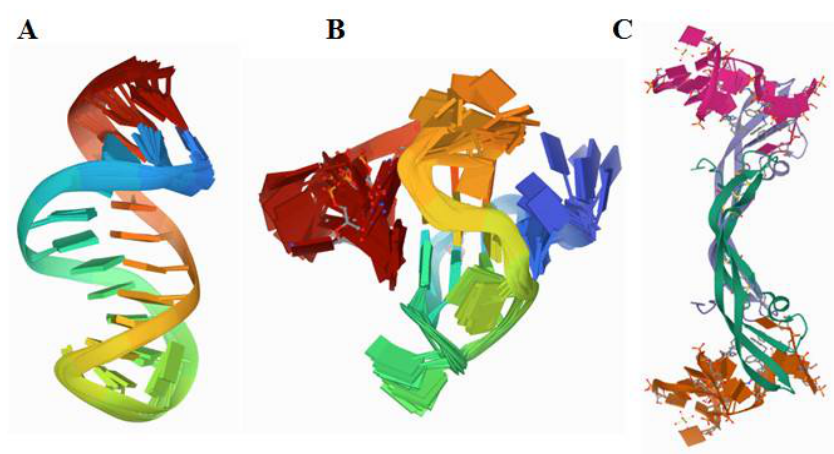
Figure 2. Structure of ( A ) a truncated 23-mer DNA MUC1 aptamer, image from the RCSB PDB (rcsb.org) of PDB ID 2L5K [18], ( B ) a VEGF aptamer with locked nucleic acid modifications, image from the RCSB PDB (rcsb.org) of PDB ID 2M53 [19], ( C ) human PDGF-BB protein in a complex with a modified nucleotide aptamer, image from the RCSB PDB (rcsb.org) of PDB ID 4HQU [20].